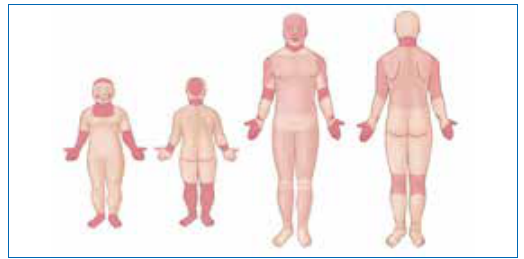
Figure 2. Common sites of AD outbreaks